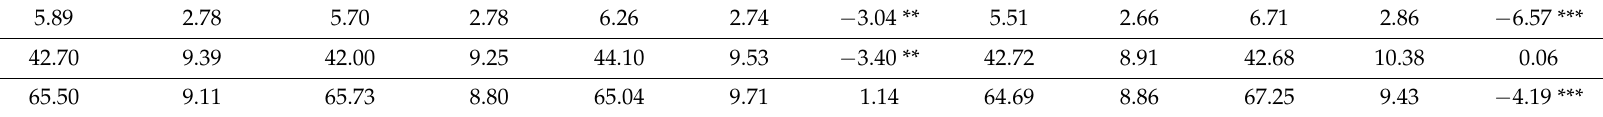
Table 2. Sex and age-group differences of the prevalence of perceptions of police procedural and distributive justice, as well as psychosocial characteristics. Overall Sample Female Male Young